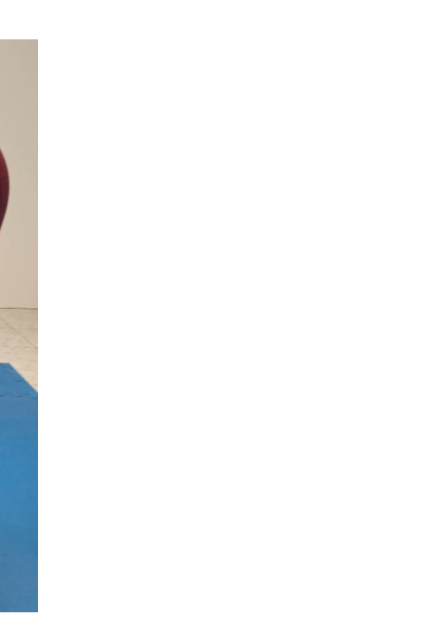
Figure 3. Measurement of thoracolumbar range of movement by using the double inclinometer method.